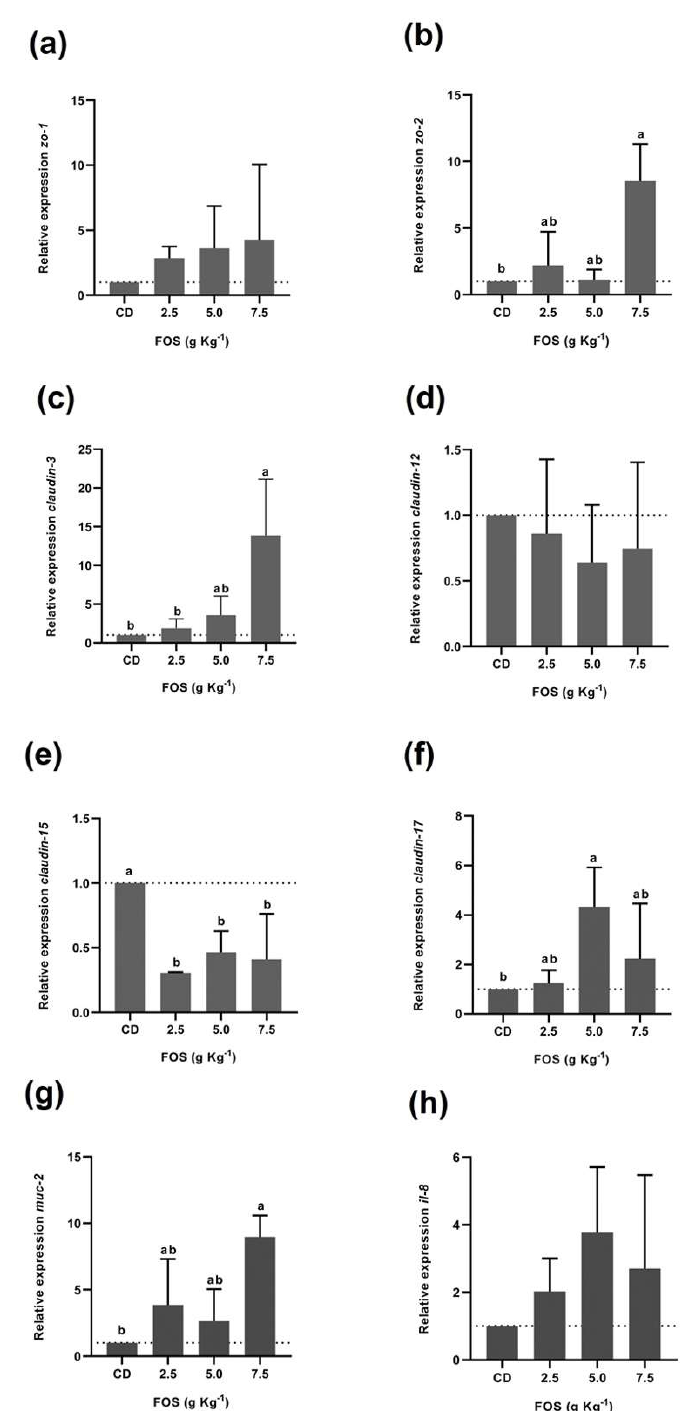
Figure 2. Expression levels of intestinal barrier function genes in A. tropicus larvae (19 DAH) fed a diet supplemented with different levels of FOS (2.5, 5.0, and 7.5 g kg − 1 ) and a diet without FOS (control diet) for 15 days. Tight junction proteins: ( a ) zo-1 , ( b ) zo-2 , ( c ) claudin-3 , ( d ) claudin-12 , ( e ) claudin-15 , ( f ) claudin-17 . Mucus layer protein: ( g ) muc-2 . Cytokine pro-inflammatory: ( h ) il-8 . The relative mRNA levels were measured by RT-qPCR using β -actin as the reference gene. Each bar represents the mean of the relative mRNA levels changes compared with larvae fed with control diet (dotted line). Values are mean ± SD. Significant differences between the diets are indicated by different letters ( p <